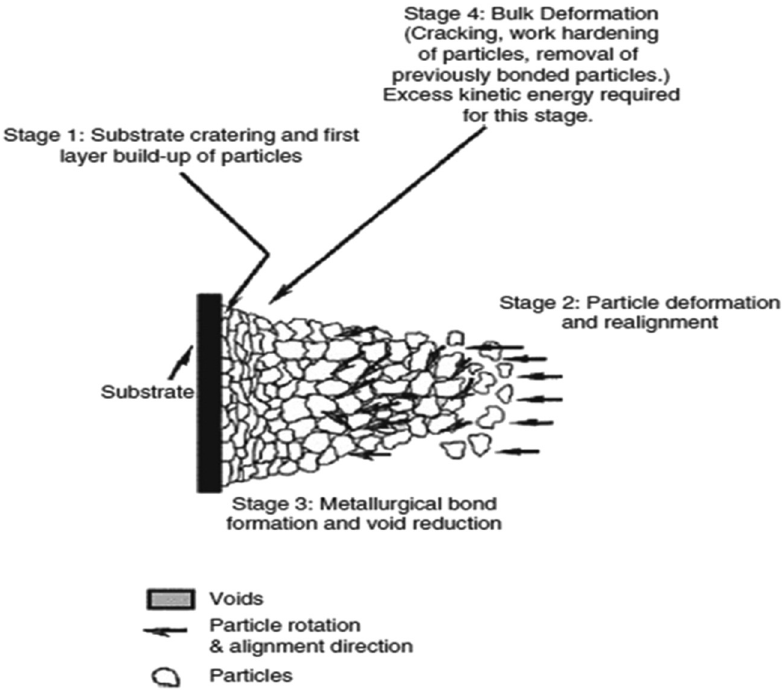
Figure 4: Stages of deposition in cold spraying [ 6 ]